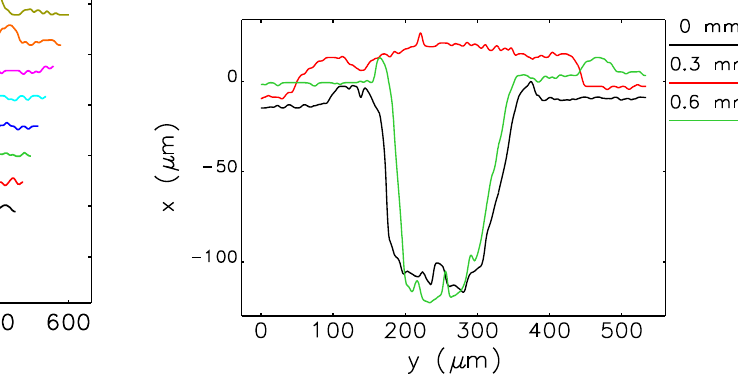
FIG. 27. Surface profiles extracted from the SN08 stack data of Fig. 26 ( z 0 ) in waterfall format. The z separation between profiles is 100 μ